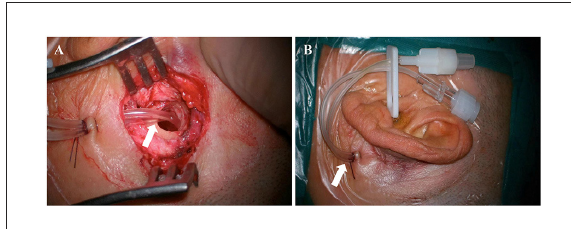
FIGURE1 Intraoperative (A) and postoperative (B) pictures of tympanic antrum catheterization (arrows).